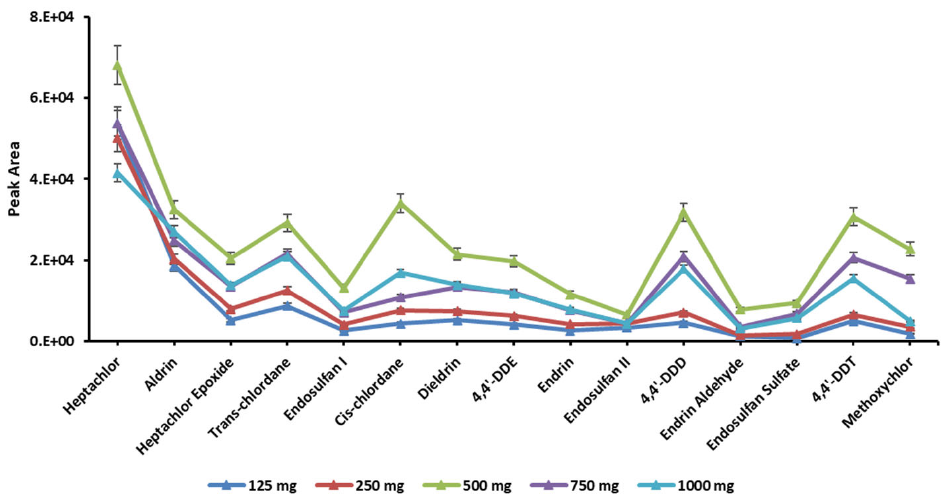
Figure 4. Optimization of mass of sample.